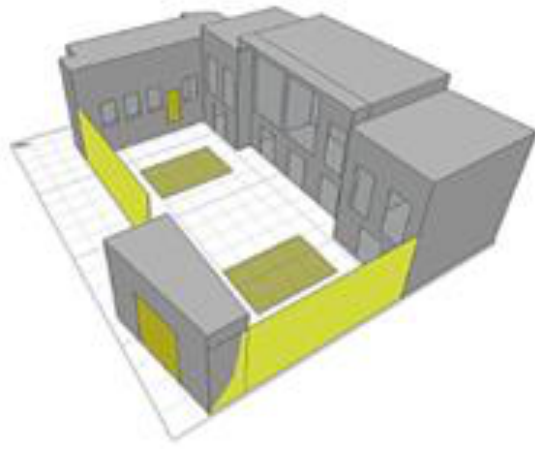
Figure 17 Geometry of house No. 4; south facing façade